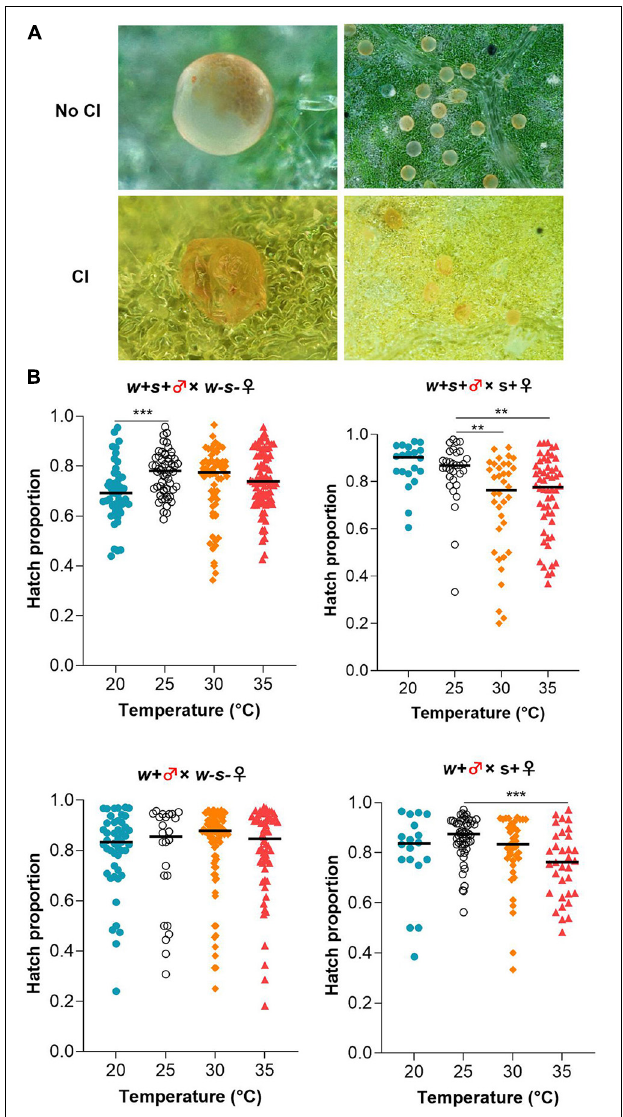
FIGURE 2 | Effect of low (20 ◦ C) and high (30 or 35 ◦ C) temperatures on Wolbachia- induced CI. (A) Visual differences in normal eggs (upper panels) and stunted eggs from CI (lower panels). (B) Egg hatch rates in four crosses between different spider mite strains at either kept under different temperatures. Horizontal bars indicate the medians based on n = 18–99 per treatment. Mann–Whitney test, ** p < 0.01, *** p < 0.001.